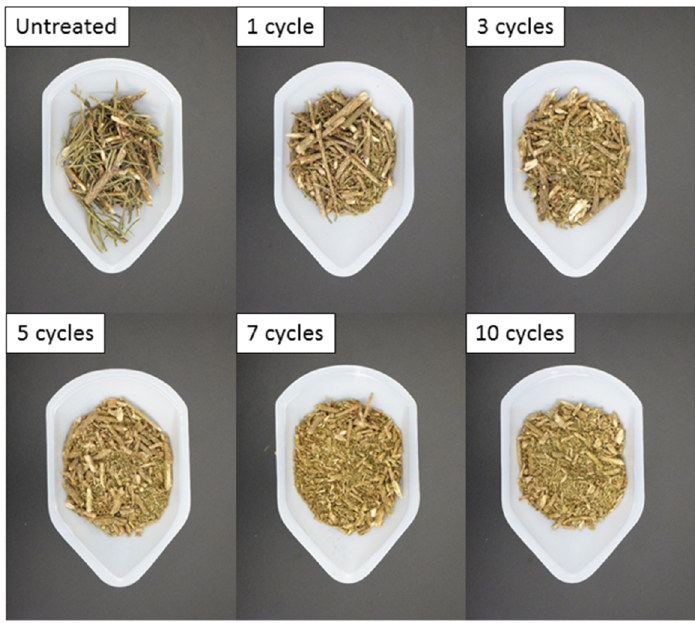
Figure 2. Images of the effects of underwater shockwave pretreatment at 3.0 kV and 3.6 kJ on dry leaves and branches for various numbers of cycles.